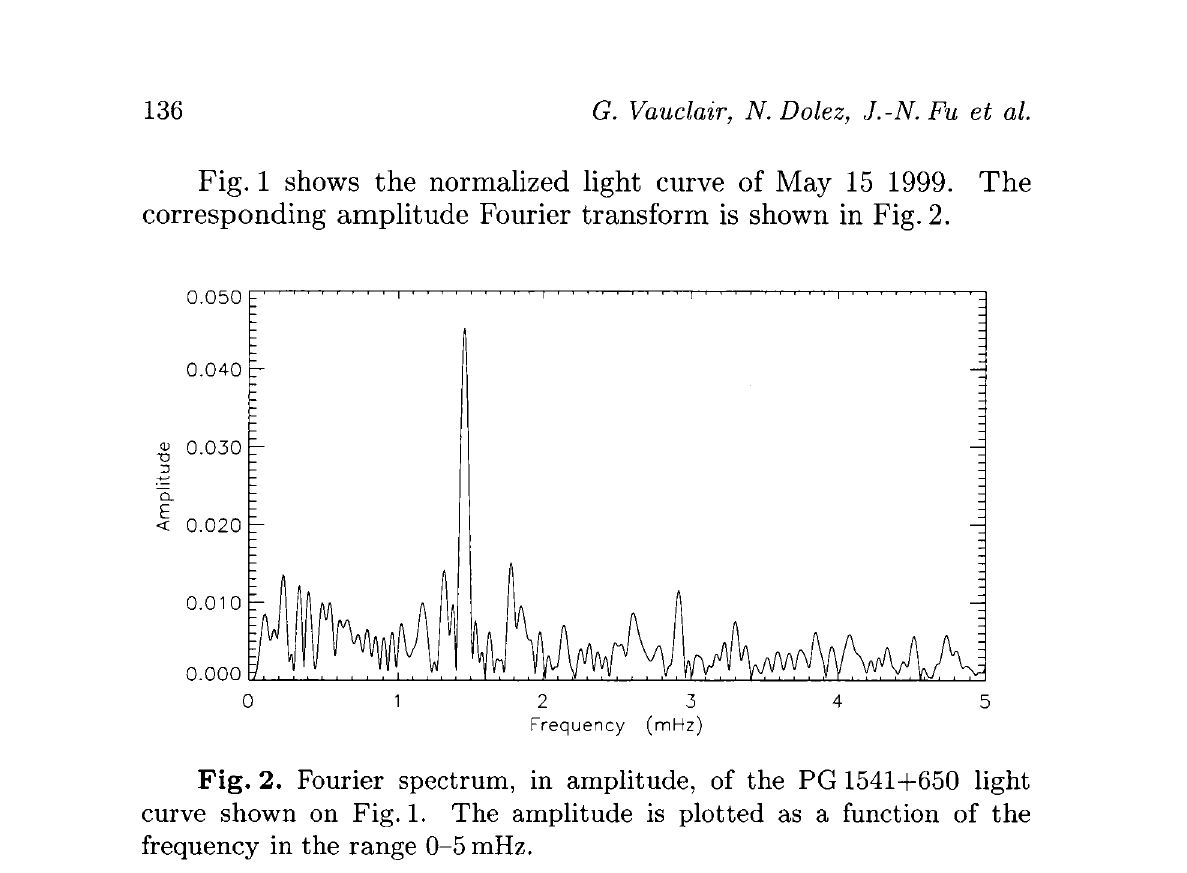
Fig. 2. Fourier spectrum, in amplitude, of the PG 1541+650 light curve shown on Fig. 1. The amplitude is plotted as a function of the frequency in the range 0-5 mHz. The noise level above 1 mHz is «¿4-5 mmag. The FT is clearly dominated by a single peak at 1.458 mHz (period of 686 s) with a relative amplitude of 0.045. The second peak is seen at 1.775 mHz (period of 563 s) with a relative amplitude of 0.015. The third peak at 1.320 mHz (period of 757 s) shows a similar relative amplitude of 0.014. The first harmonics of the dominant peak is also seen at 2.912 mHz with a relative amplitude of 0.012. The frequency resolu- tion from this single night is 48 ¿xHz. The data obtained on August 23, 1998 and on May 14, 1999 show the same large amplitude peak which is at 1.416 mHz and 1.463 mHz respectively, with a larger un- certainty due to the lower frequency resolution. The dominant peak has approximately maintained a constant amplitude since the discov- ery run. The second frequency is also present, within the uncertainty of the reduced resolution data at 1.877 mHz and 1.856 mHz respec-